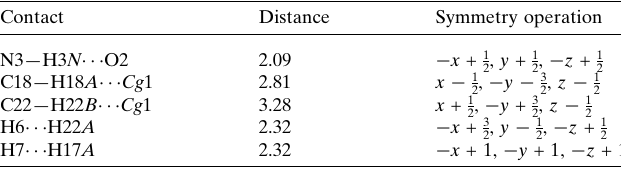
Table 3 A summary of short interatomic contacts (A˚ ) for (I) a . Contact Distance Symmetry operation